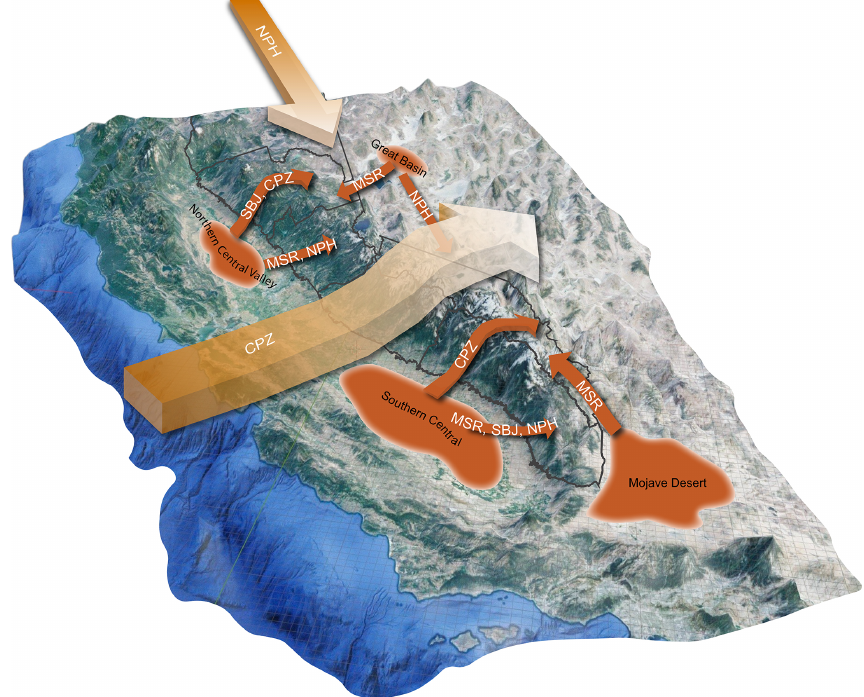
Figure 14. Schematic diagram of typical dust transport patterns across the Sierra Nevada. “MSR” denotes mesoscale regional transport. “SBJ” and “NPH” denote dust transport dominated by Sierra barrier jets (SBJs) and the North Pacific High (NPH), respectively, while “CPZ” denotes cross-Pacific zonal